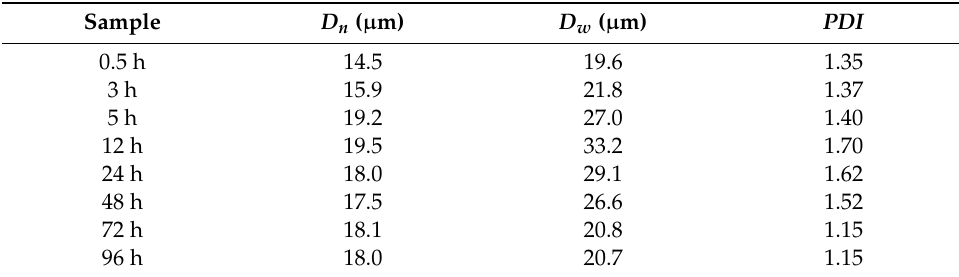
Table 6. D n , D w , and PDI of asphalt particles for di ff erent curing times.